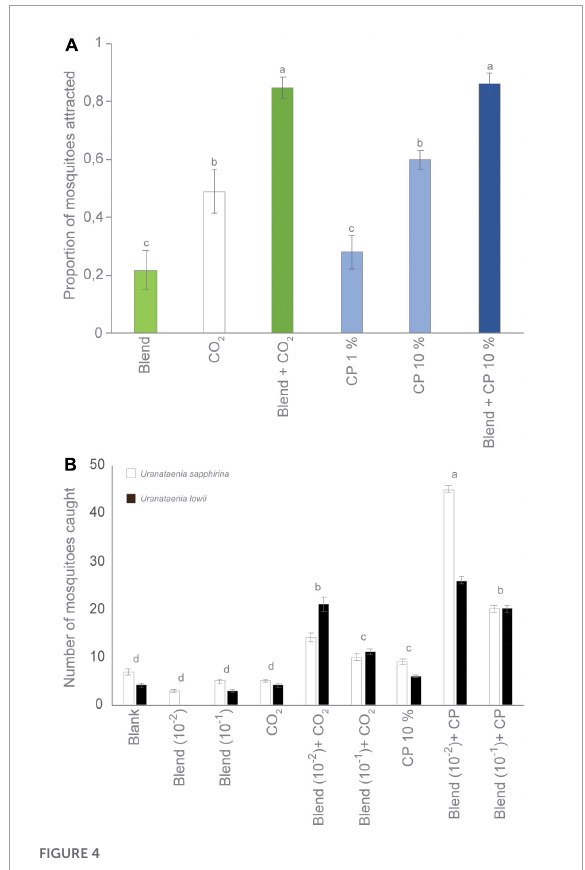
FIGURE4 Differential response of mosquitoes to the carbon dioxide (CO 2 ) receptor agonist, cyclopentanone. (A) Under laboratory conditions, cyclopentanone (CP) reproduced the behavioral response of Culex quinquefasciatus to CO 2 in the presence or absence of the synthetic chicken odor blend. A nominal logistic fit model was used for statistical analysis. Lowercase letters indicate significant differences by odd ratios (likelihood ratio test) in pairwise comparisons, P < 0.05. Error bars denote standard error of the mean ( N = 10). (B) Tested under field conditions at Cedar Key Scrub State Reserve (FL, United States) ( Figure 2B ), traps baited with cyclopentanone, in combination with the synthetic chicken odor, caught significantly overall higher number of Uranataenia sapphirine and Uranataenia lowii when compared to traps baited with cyclopentanone alone, and to control traps, when analyzed using a mixed effects model. The two Uranataenia species were also attracted to, and caught in, traps baited with CO 2 and a low dose of the synthetic chicken odor blend. Lowercase letters indicate significant differences by, P < 0.05. Error bars denote standard error of the mean ( N =